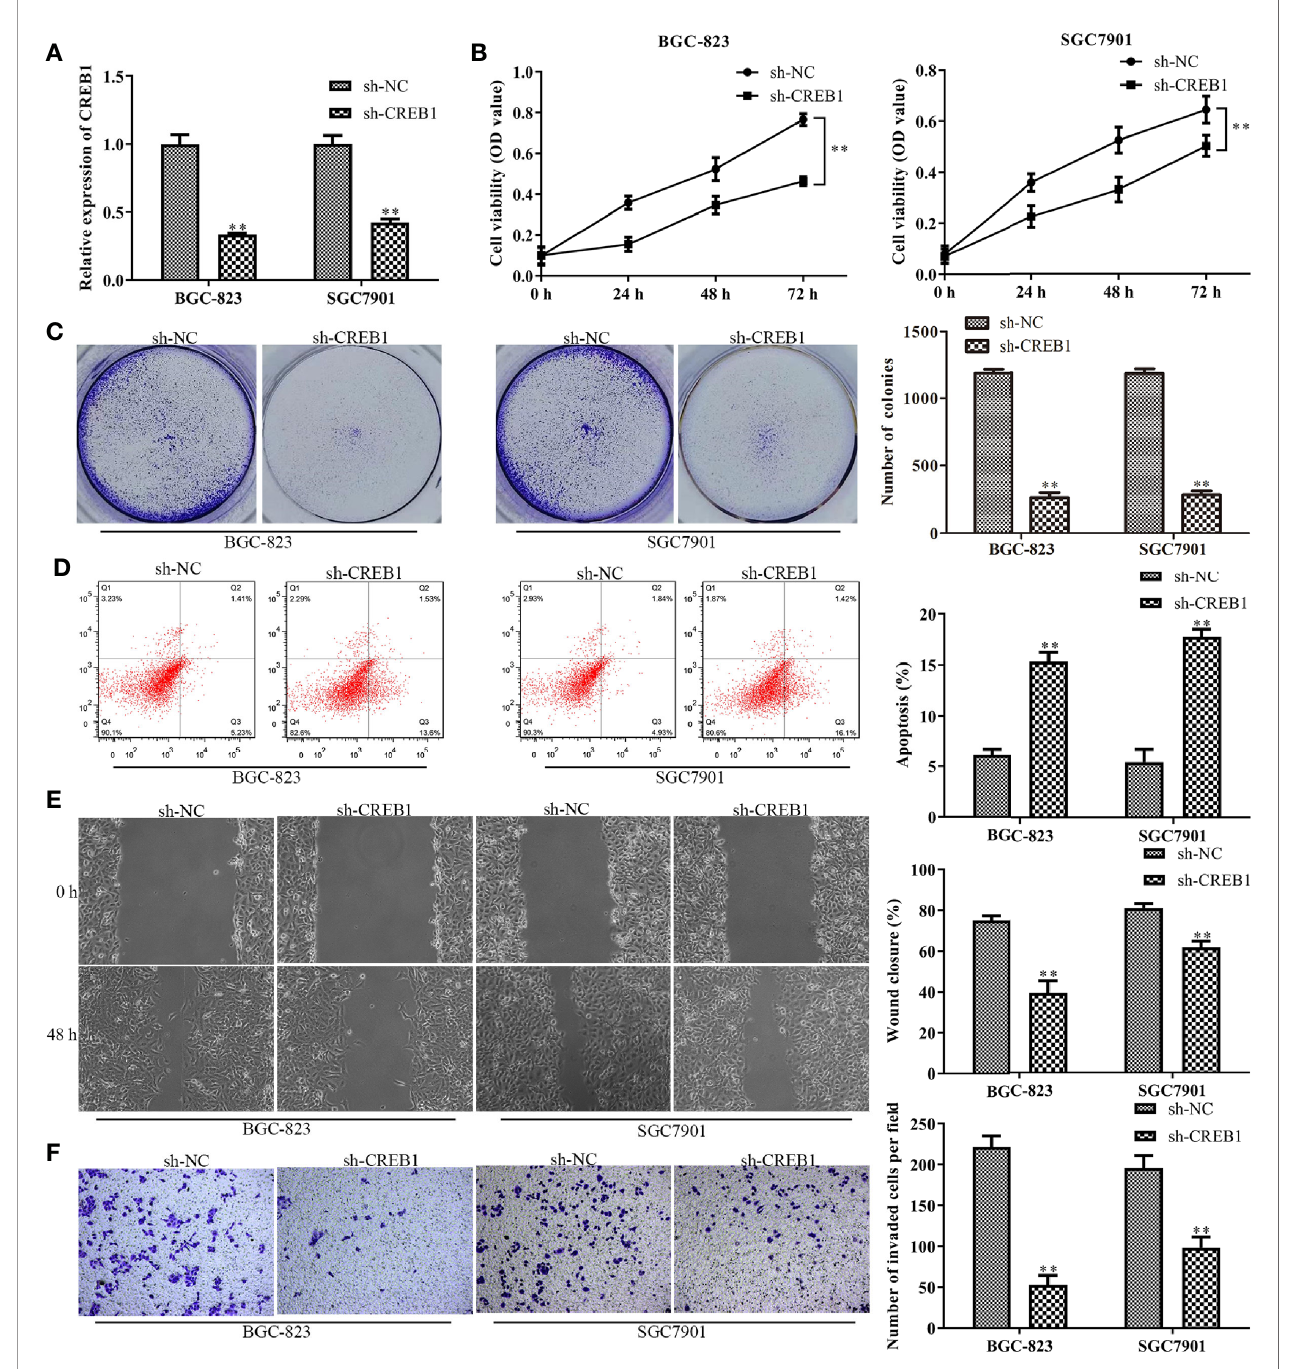
FIGURE 5 | Knockdown of CREB1 affects gastric cancer cell proliferation, apoptosis, migration, and invasion. (A) RT-qPCR evaluated the ef fi ciency of CREB1 knockdown in BGC-823 and SGC-7901 cells. (B, C) CCK-8 and colony formation assays on the cell proliferation of BGC-823 and SGC-7901 cells after knockdown of CREB1. (D) Flow cytometry on the cell apoptosis of BGC-823 and SGC-7901 cells after knockdown of CREB1. (E, F) Wound healing and transwell chamber assays on the cell migration and invasion of BGC-823 and SGC-7901 cells after knockdown of CREB1. ** P <0.01 vs. sh-NC